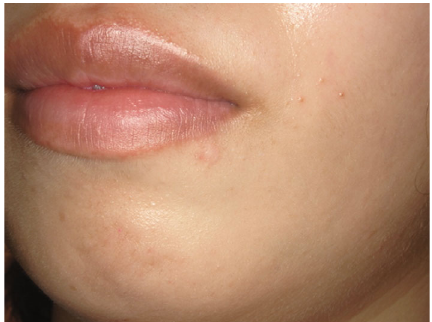
Figure 4: Extraoral fi nding 10 months after the